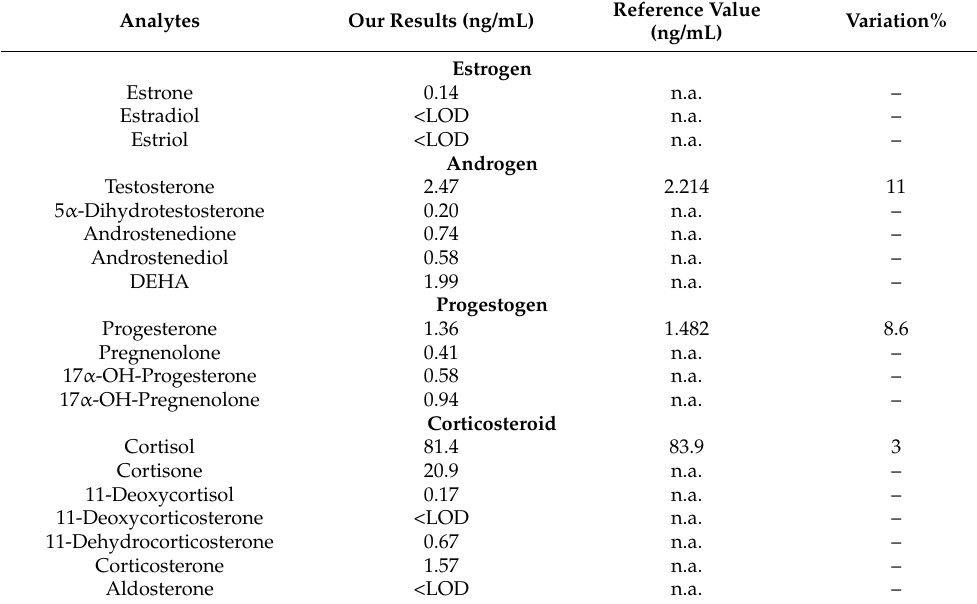
Table 4. Steroid hormones measured in plasma Standard Reference Material (SRM1950) using the method developed in this study and compared to the certified reference values. Reference values were only available for cortisol, progesterone, and testosterone. Reference Value Analytes Our Results (ng/mL)